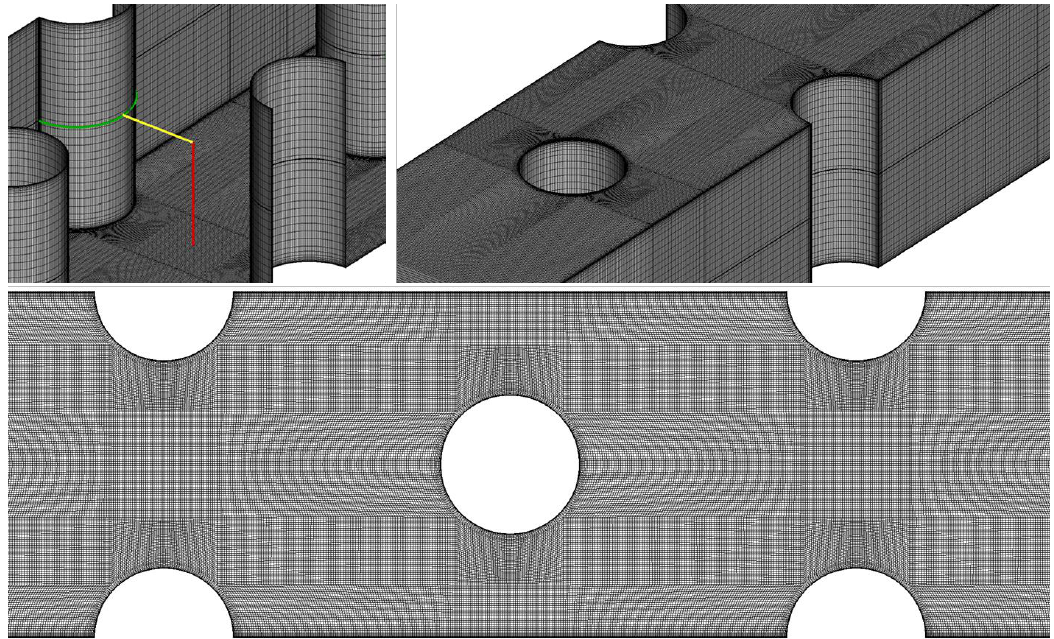
Figure 2. The structured mesh and the lines used to display the results. Line A (red): end-wall normal line; line B (yellow): pin normal line; line C (green): line along the pin.